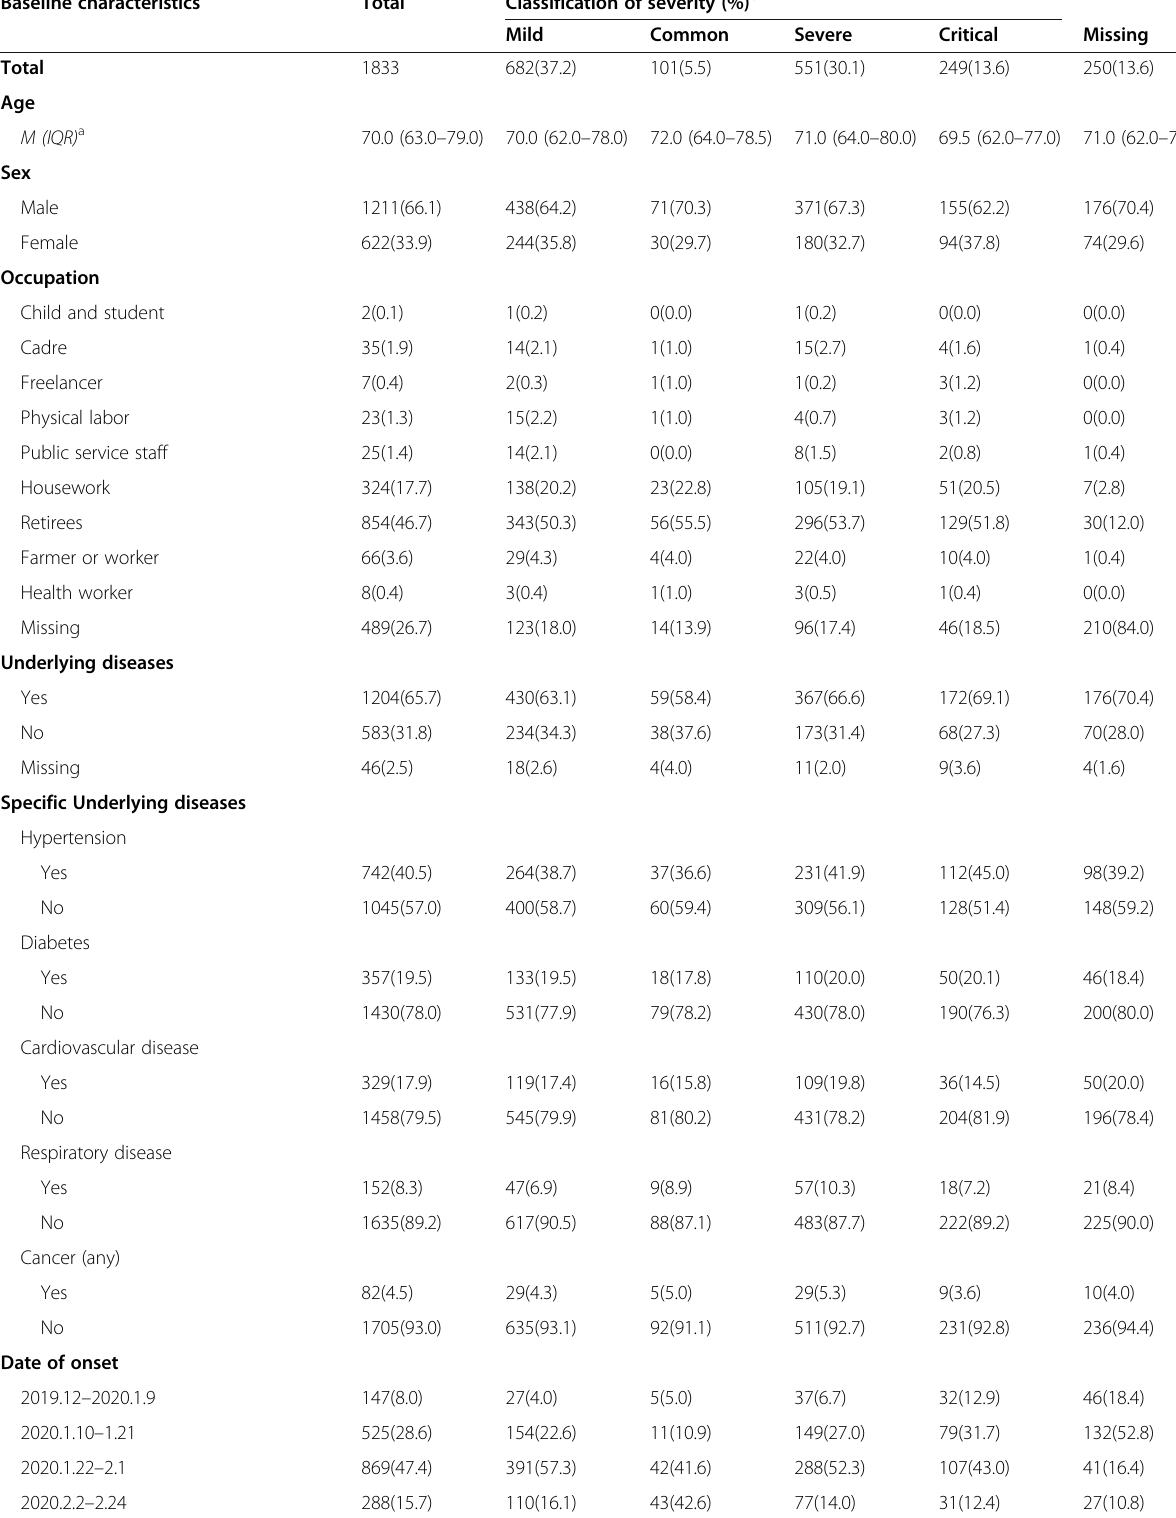
Table 1 The epidemiological characteristics of deceased patients of COVID-19 infection with different severities in Wuhan during the early